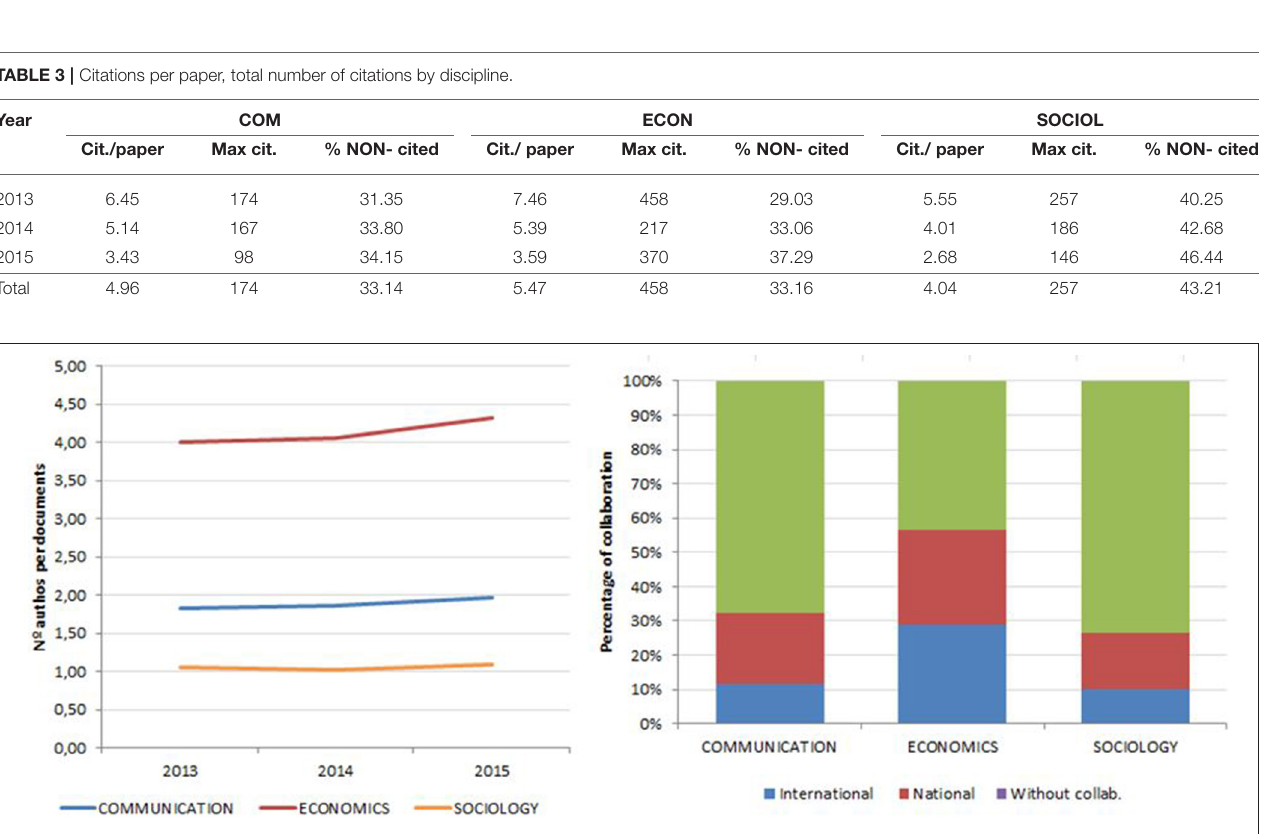
FIGURE 4 | Yearly co-authorship rates (Left) and institutional collaboration by discipline (right)